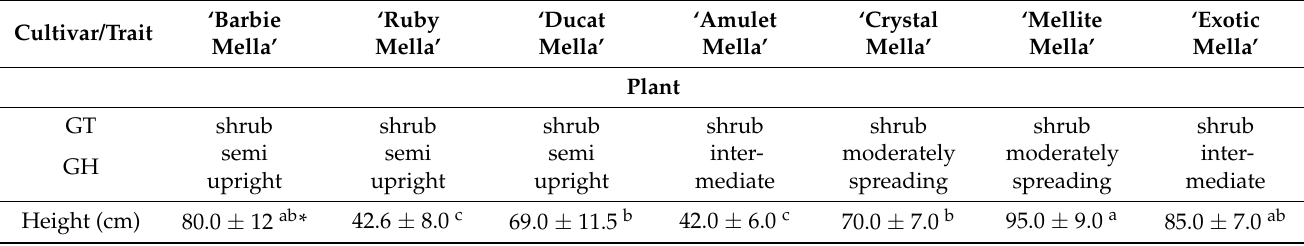
Table 1. Qualitative and quantitative vegetative characteristics of the investigated ‘Mella’ rose